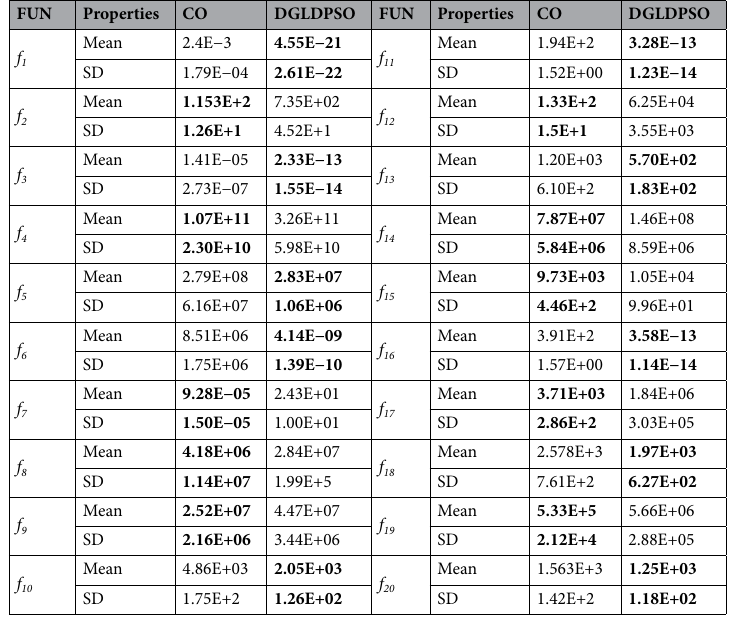
Table 7. Results of CO and DGLDPSO on the CEC2010 large-scale functions. Significant values are in